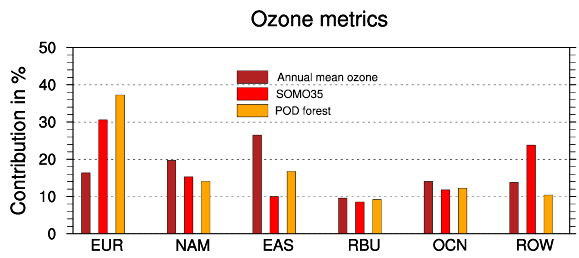
Figure 6. Contributions to ozone metrics annual mean ozone, SOMO35 and POD 1 forest in percent (where BASE–GLOALL rep- resents 100%) as calculated by the EMEP_rv48 model. The met- rics have been scaled so that the difference between the BASE– GLOALL (20% anthropogenic emission reductions) calculations is 100% (the sum of EUR, NAM, EAS, RBU, OCN and ROW is